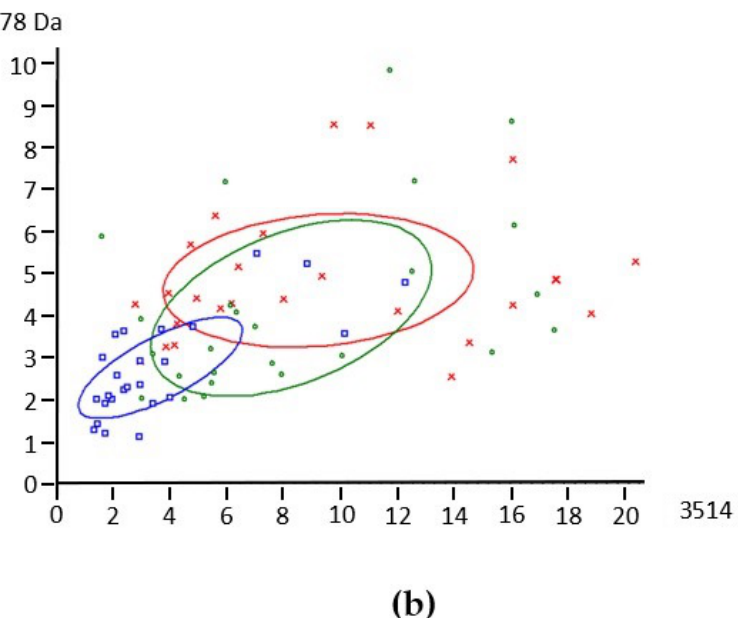
Figure 1. ( a ) Gel-like view and average spectrum. ( b ) 2D-plot protein spectra according to the intensities of m / z 3178 and m / z 3514 from colostrum (red), transitional milk (green) and mature milk (blue) from NW mothers. Number of points = 72 (8 subjects, 3 milk types, 3